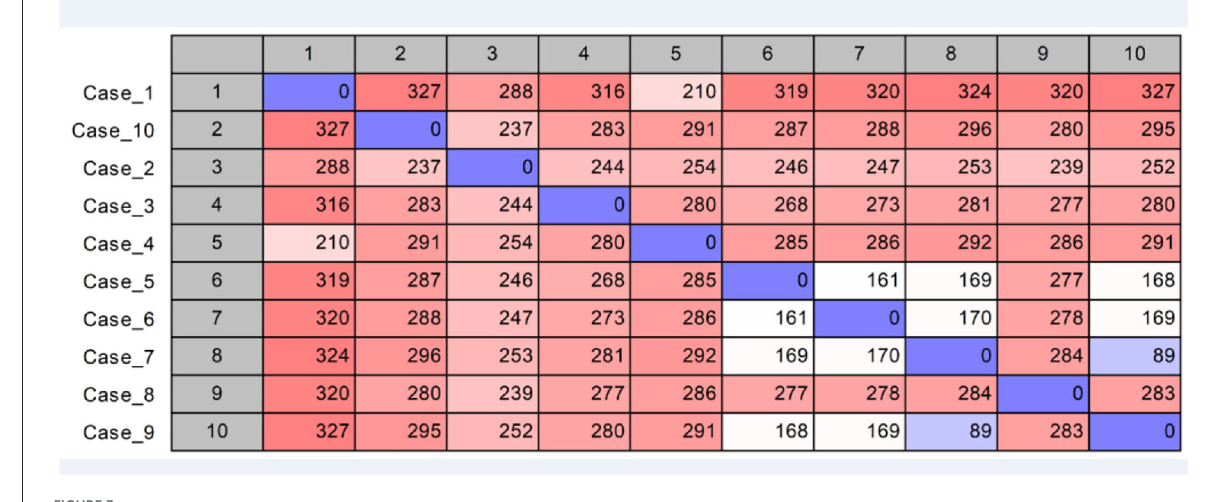
FIGURE3 SNP analysis of K1-ST23 isolates using NTUH-K2044 (GenBank accession AP006725) as the reference